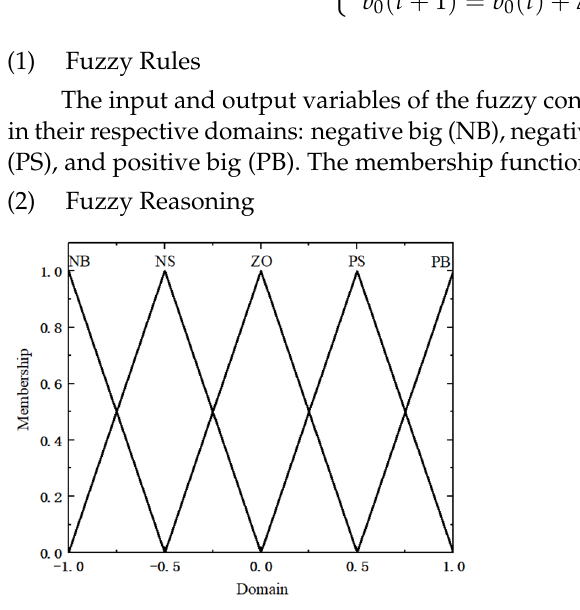
Figure 2. Triangular membership function.